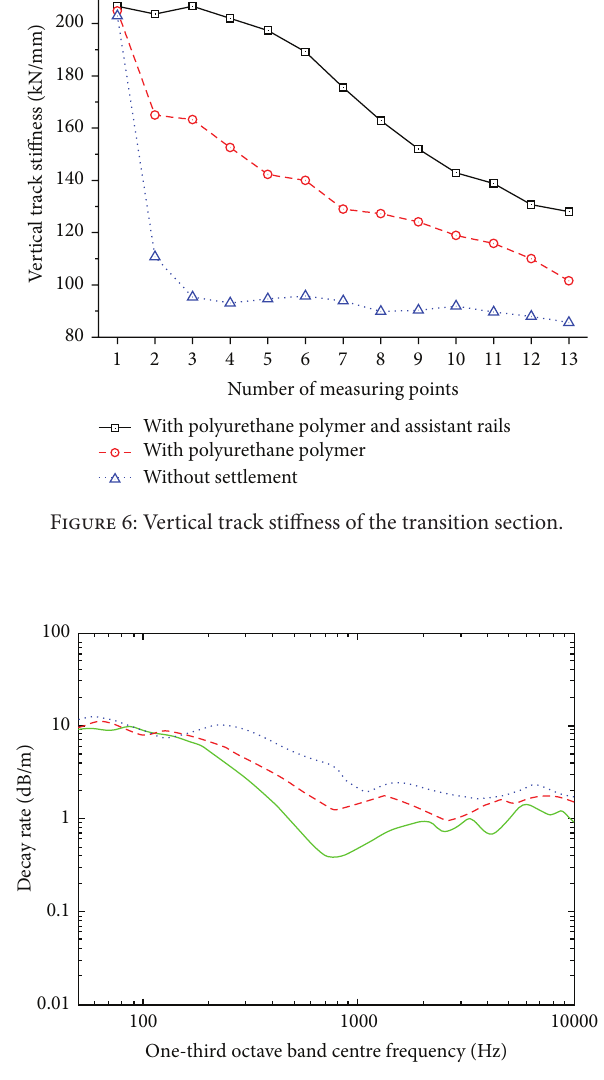
Figure 7: Measured track decay rates: without settlement (green line), with polyurethane polymer alone (red line), and with the combination use of polyurethane polymer and assistant rails (blue